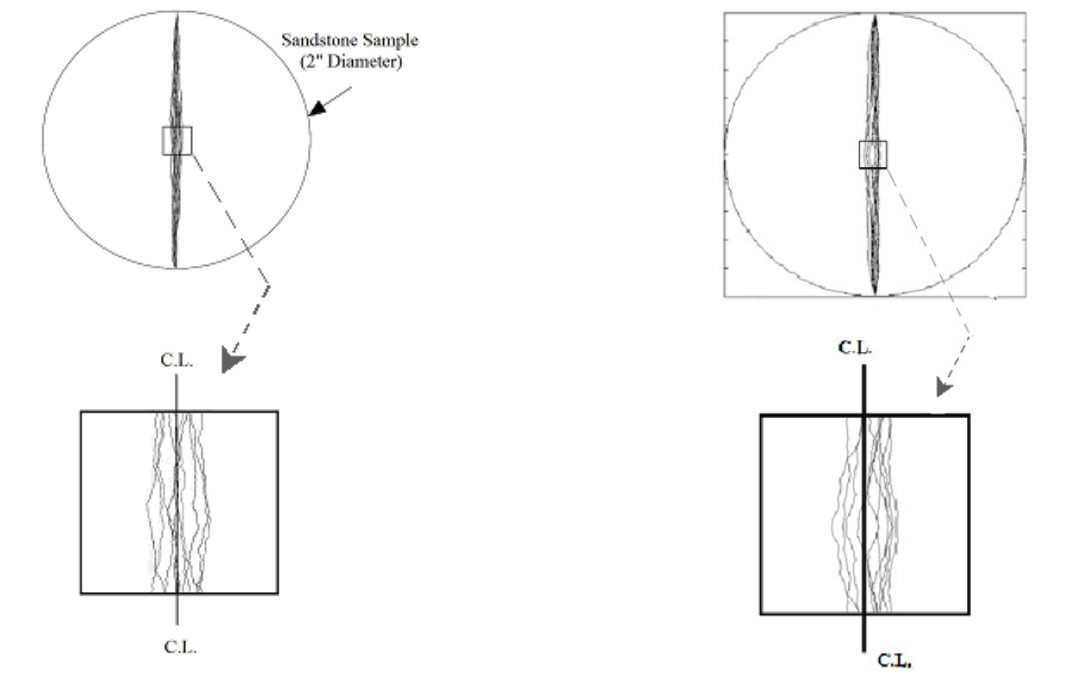
Figure 1: Experimentally observed crack trajectories in sandstone discs.